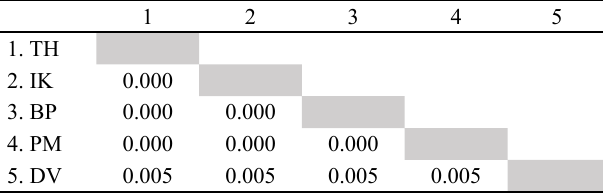
Table 4 . Pairwise genetic distance (p-distance) in species under study.